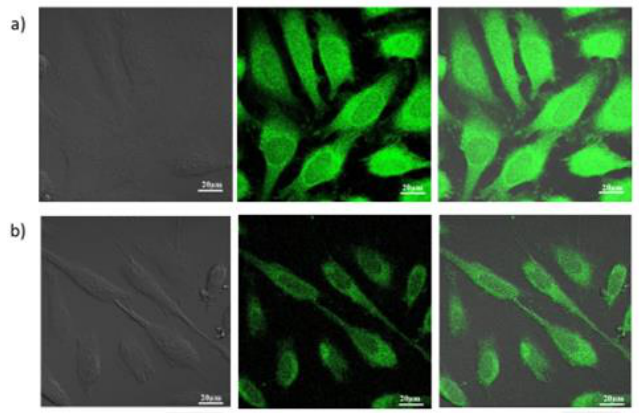
Figure 5. Fluorescent image of HeLa cell after incubation with ( a ) 3O and ( b ) 4O .